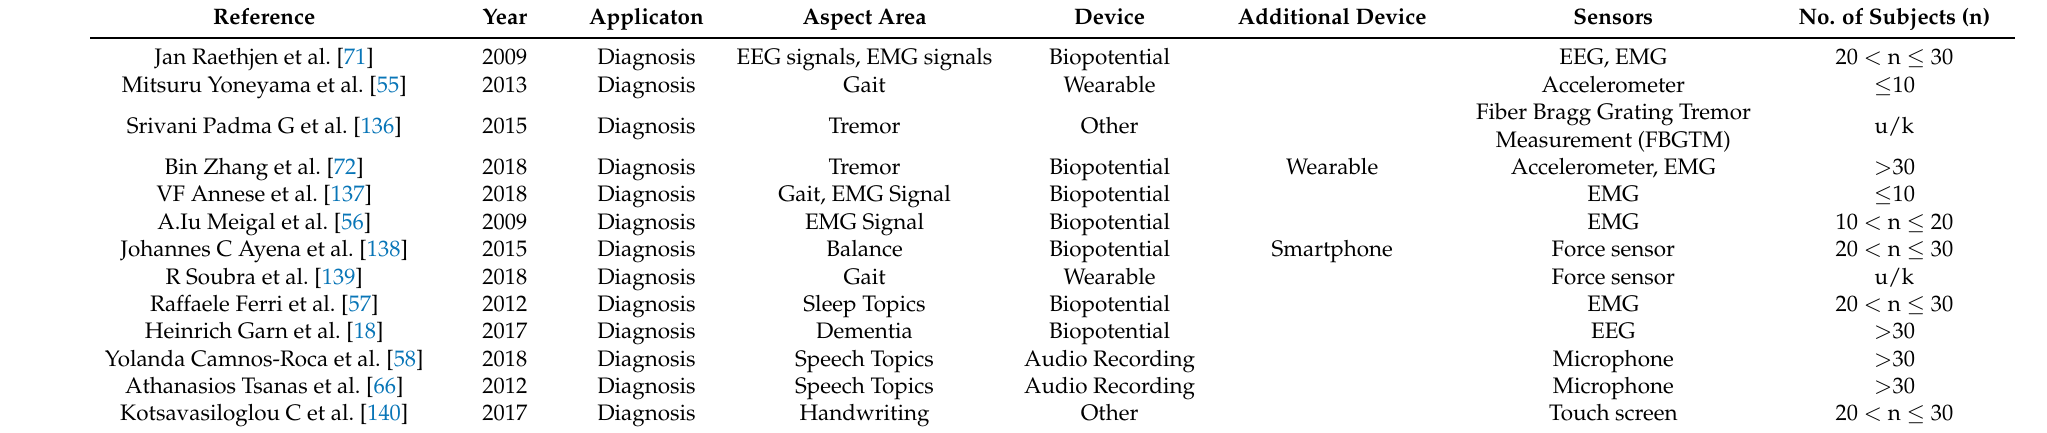
Table A4. Papers about diagnosis, early diagnosis and differential